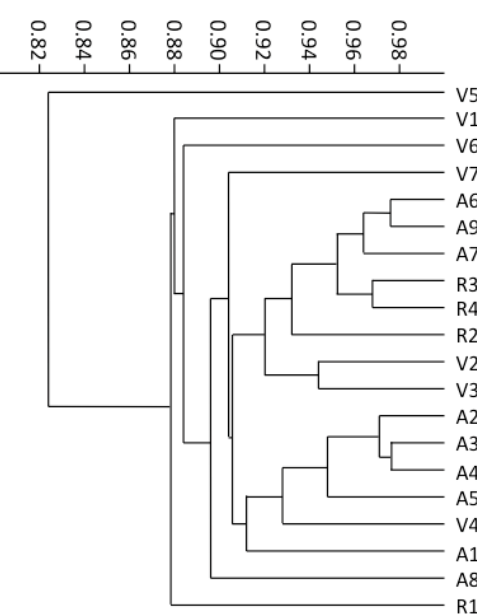
Figure 4. Dendrogram obtained with RAMP markers, using the nine combinations of primers, for the plants obtained by in vitro germination of the three collections A (A1–A9), R (R1–R4), and V